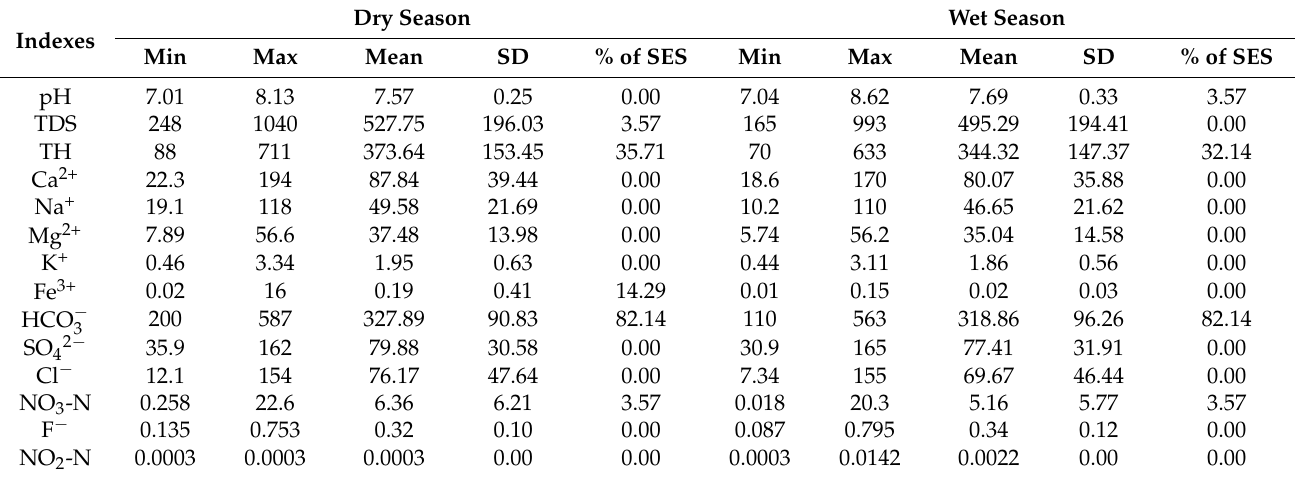
Table 3. Statistical analysis of chemical composition of